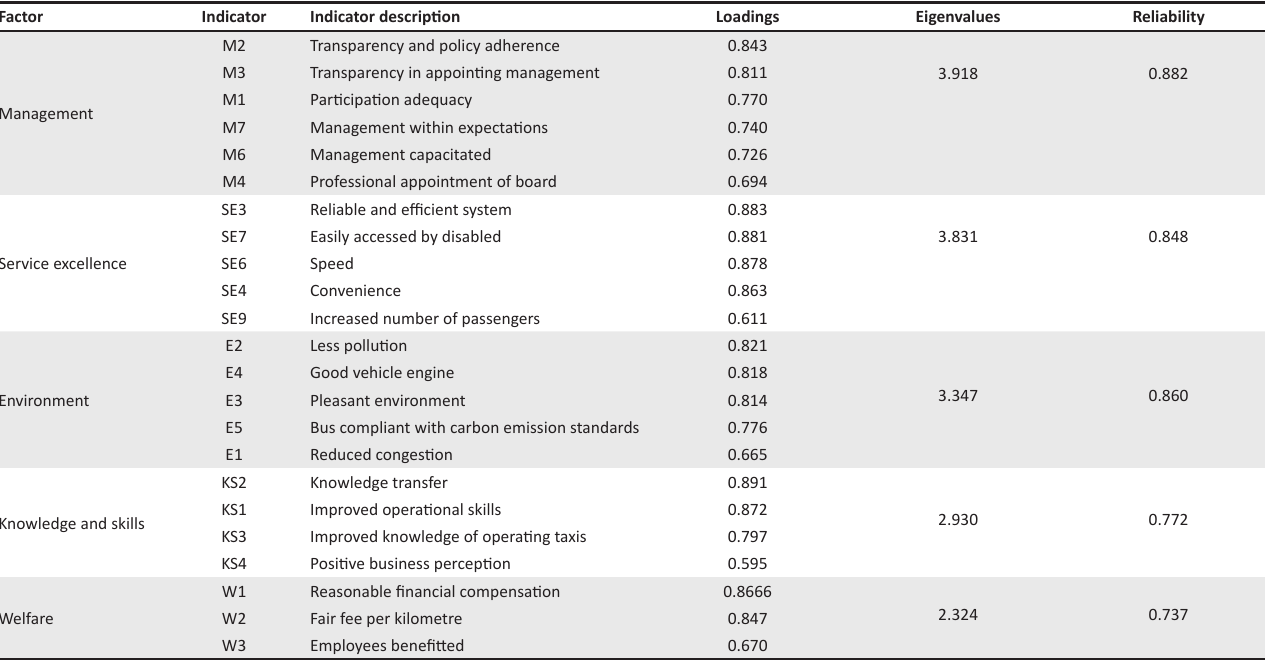
TABLE 4: Results of factor analysis for former taxi operators. Factor